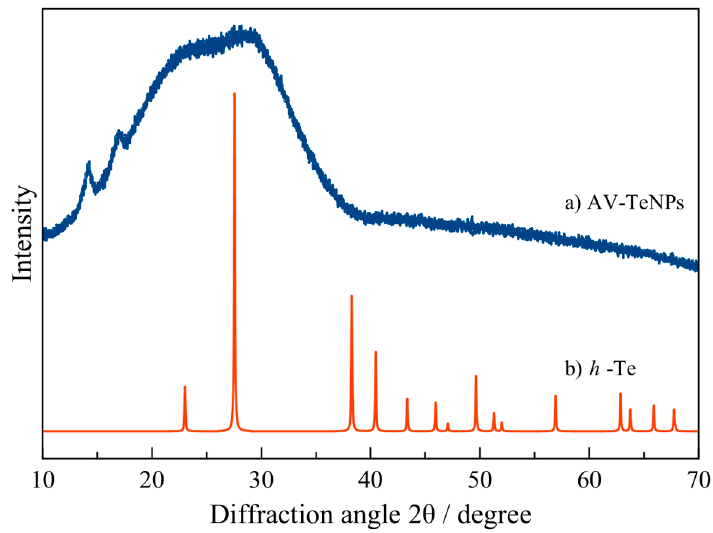
Figure A3. XRD analysis of the AV-TeNPs.